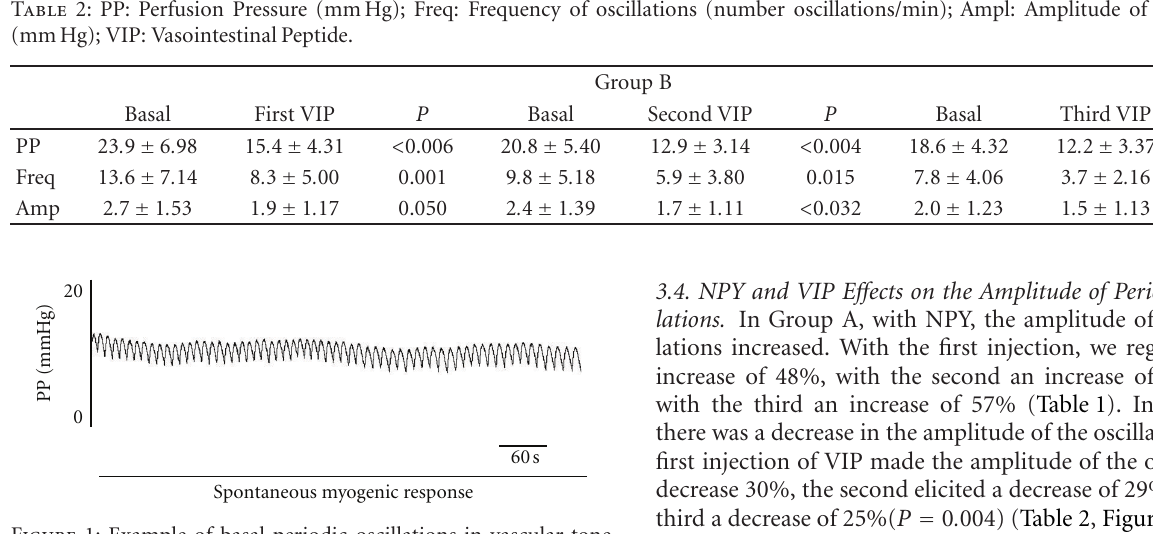
Figure 1: Example of basal periodic oscillations in vascular tone observed before any drug administration. On the x axis, the perfu- sionpressure recorded at the rabbit external ophthalmicartery is re- presented in mm Hg. In the y axis, we represent the time in